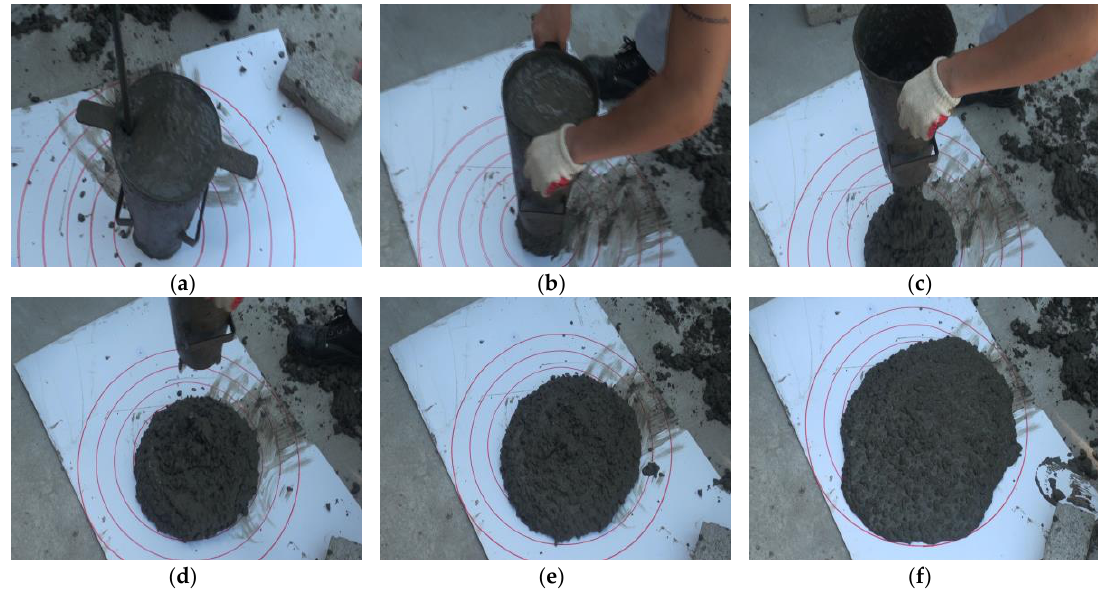
Figure 1. Slump flow test: ( a ) Slump cone filled with fresh concrete; ( b ) Start of slump flow test; ( c ) Flow of concrete from cone; ( d ) Concrete slump after lifting up cone; ( e ) Spreading concrete slump; ( f ) Final concrete slump.